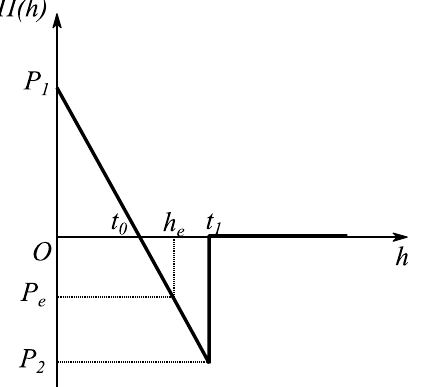
Figure 2. Selected disjoining/conjoining pressure isotherm. Reproduced with permission from